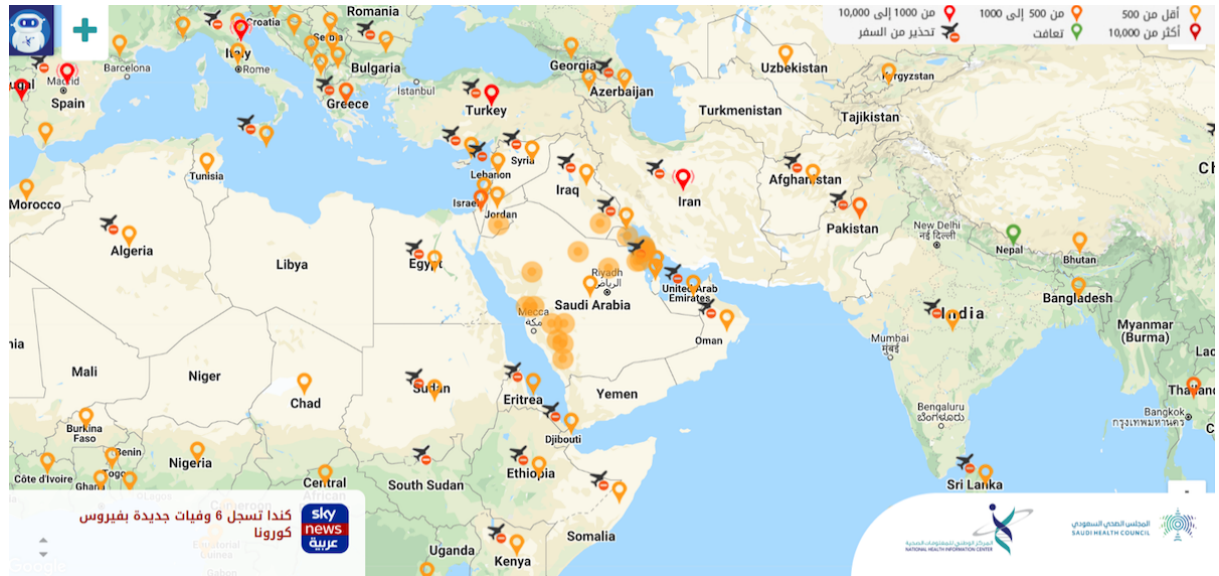
Figure 5. The Arabic language Corona Map provided by the National Health Information Center, under the Saudi Health